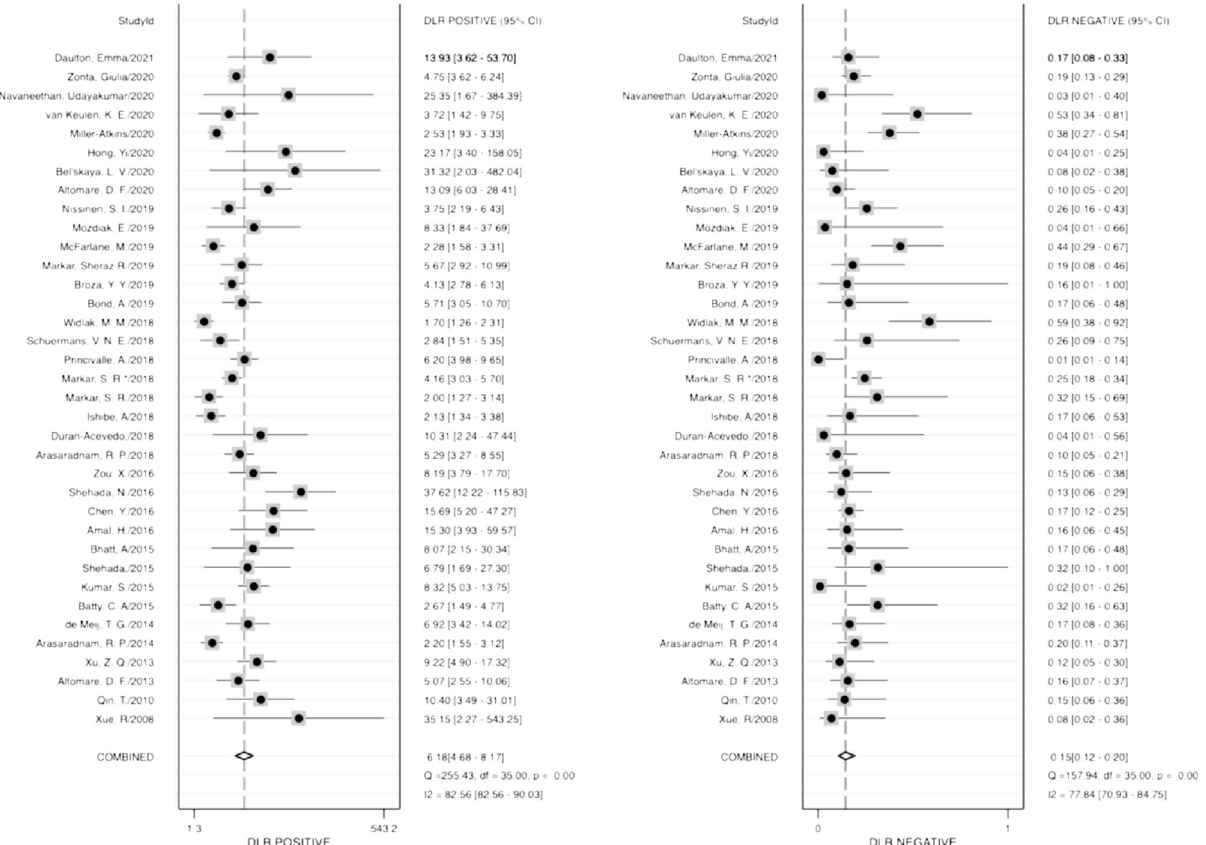
Figure 3. Forest plots of pooled positive likelihood radio and negative likelihood